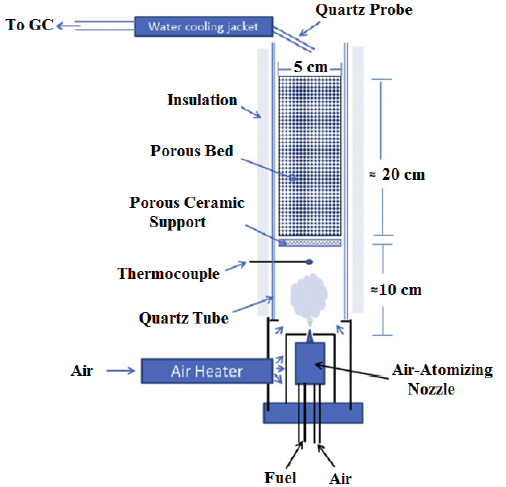
Figure 10. Experimental setup with reactor [25].